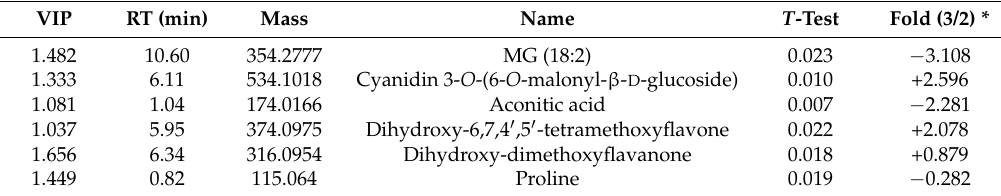
Table 3. The main identification obtained between 2 days and 3 days in ESI+ ( p < 0.05).